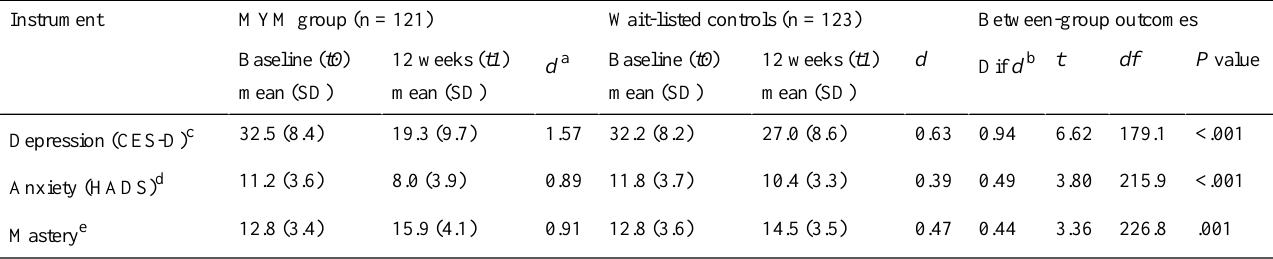
Table 3. Effects of Master Your Mood (MYM) course: intention-to-treat analysis of full sample, expectation-maximization imputation.